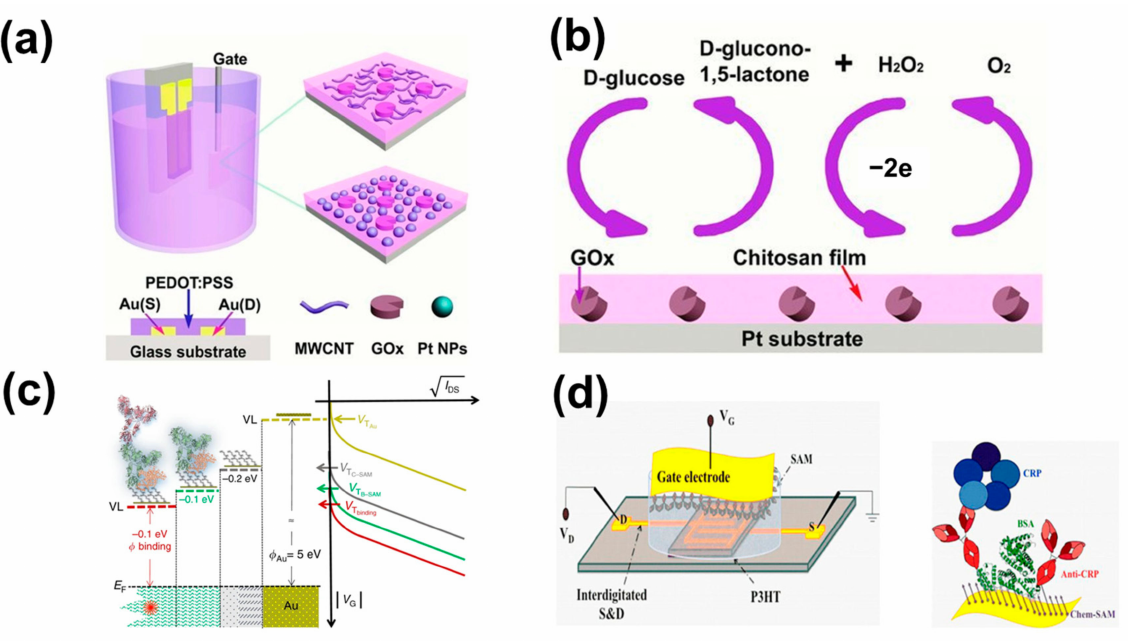
Figure 1. ( a ) The schematic representation of the component construction of PEDOT:PSS. ( b ) The reaction cycle of glucose in OECTs. ( c ) Variation in I ds of two different systems as they form a new surface. ( d ) The schematic diagram of the SiMoT biosensing platform based on OTFTs. ( a ) Reproduced with permission [16]. Copyright 2014, John Wiley and Sons. ( b ) Reproduced with permission [16]. Copyright 2014, John Wiley and Sons. ( c ) Reproduced with permission [19]. Copyright 2018, Springer Nature. ( d ) Reproduced with permission [20]. Copyright 2019, Springer